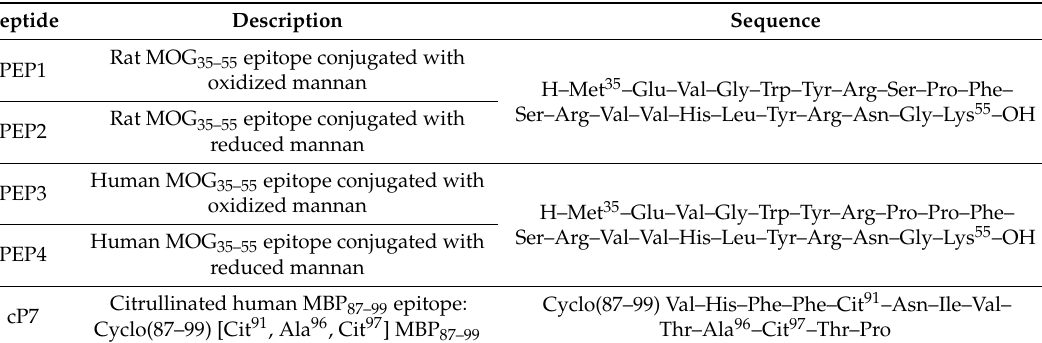
Table 2. Peptides used for the functional